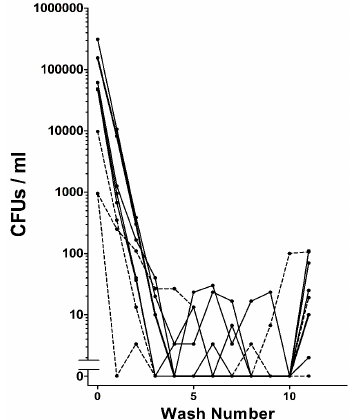
Figure 5. Removal of bacteria from HDCs by washing. The results from 8 trials with 10 HDCs being washed in each trial are shown. The final number in each trail is the number of bacteria associated with the HDCs after removal from wash 10. In 7 out of 8 trials, there were no bacteria observed in wash 10. However, in 7 out of 8 trials, there were bacteria associated with the HDCs.